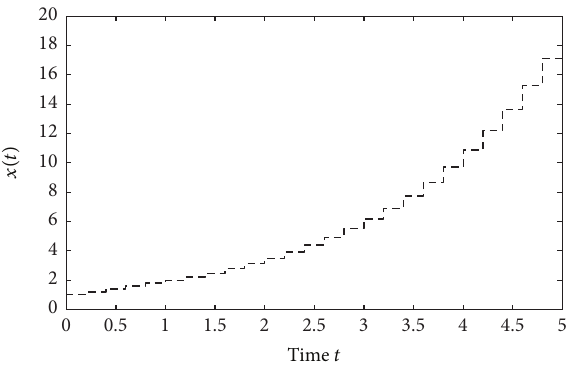
Figure 1: Instability of the stochastic delay system (23) without impulsive effect.